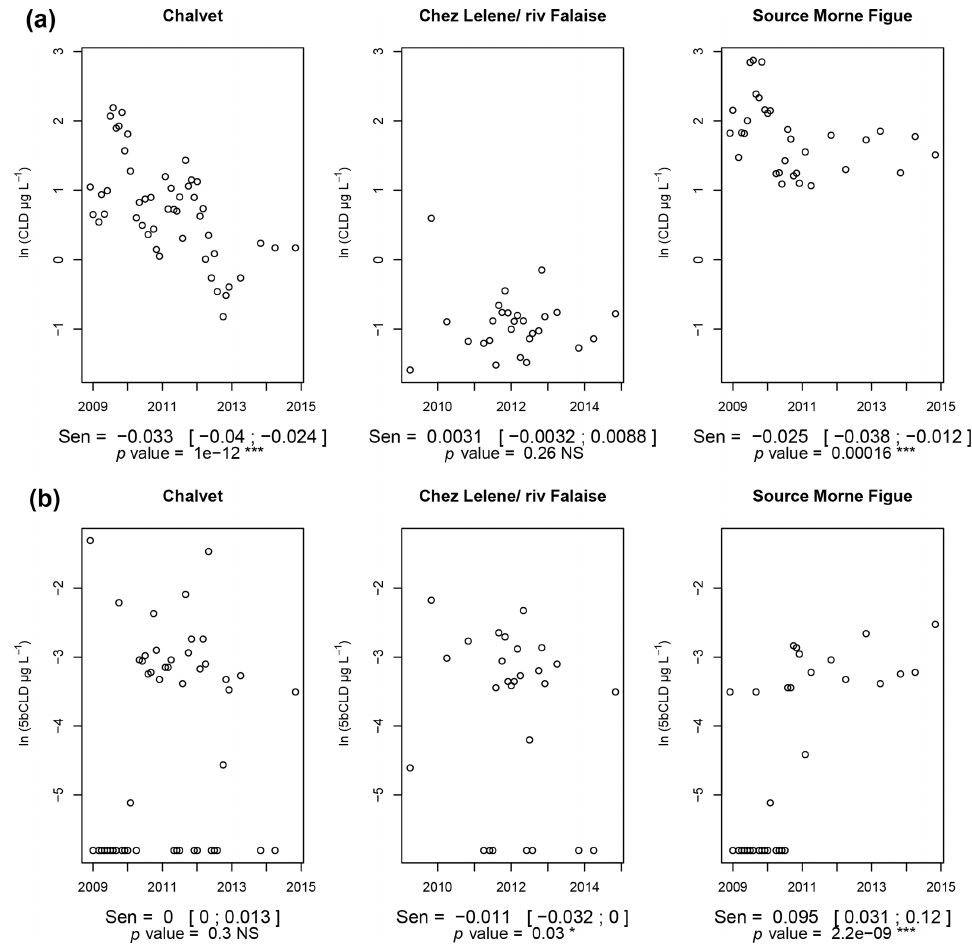
Figure 5. CLD (a) and 5bCLD (b) trends in GW for the three longest time series (the y scale is in natural logarithm). Soil and geology are andosol and 0.1My to present for the Chalvet and Chez Lelene sites and nitisol and 16.1 to 8.5My for the Source Morne Figue site. Sen trends and p values show a significant CLD decrease for Chalvet and Source Morne Figue. We found 5bCLD decreased at Chez Lelene while it increased at Source Morne Figue.